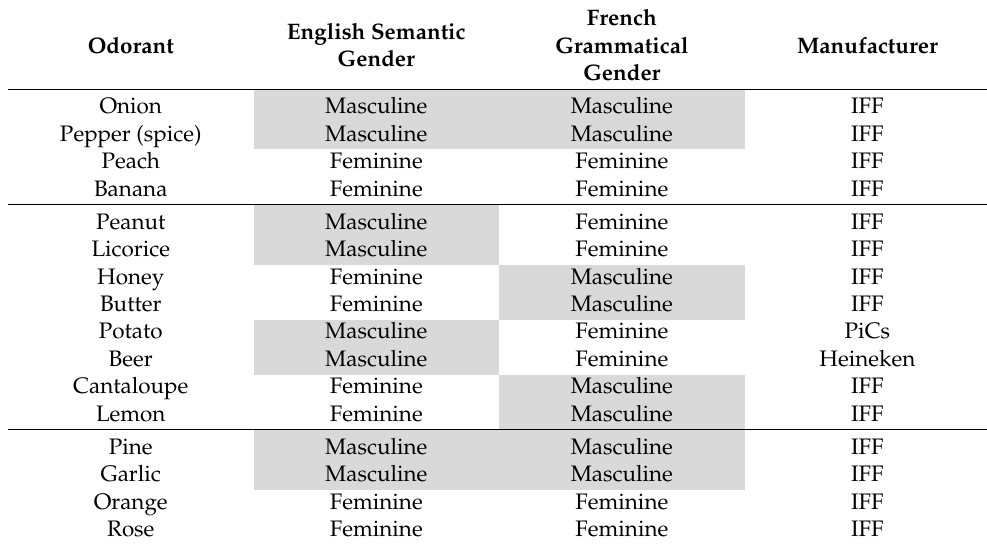
Table 2. Semantic (anthropomorphized) and Grammatical Genders of Odorants by Language. Mas- culine gender in both languages is on a gray background for reading clarity. Classification of anthropomorphized gender for native English speakers is based partially on the work of Wright, White, and Zampini [56] and partially on pilot studies. International Flavors and Fragrances (IFF) was the primary manufacturer of the odorants listed in this